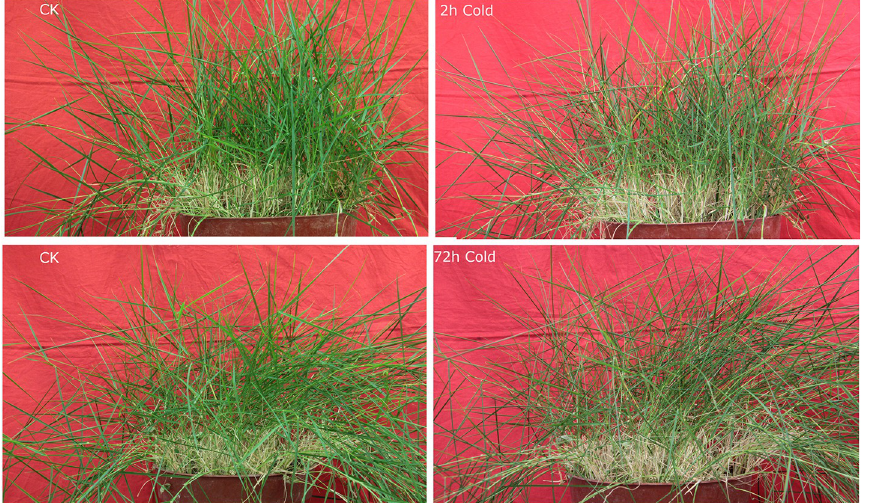
Fig 6. Morphology of Manila grass under cold